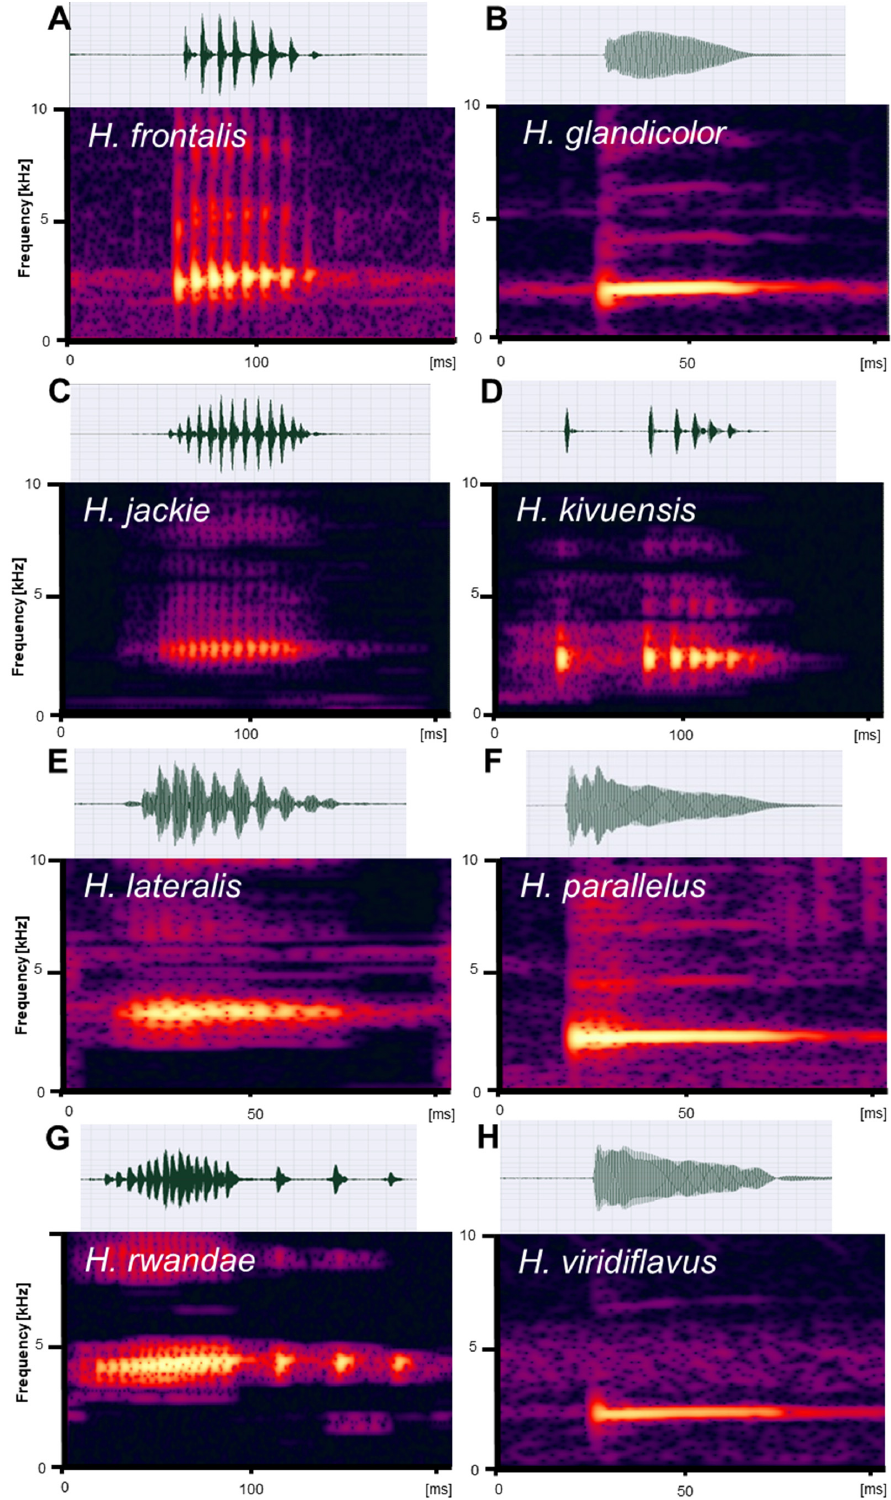
Figure 9. Advertisement calls of Hyperoliidae in Rwanda, II. ( A ) Hyperolius frontalis , ( B ) Hyperolius glandicolor , ( C ) Hyperolius jackie , ( D ) Hyperolius kivuensis , ( E ) Hyperolius lateralis , ( F ) Hyperolius parallelus , ( G ) Hyperolius rwandae , ( H ) Hyperolius viridiflavus . Calls are shown as representative spectrograms and